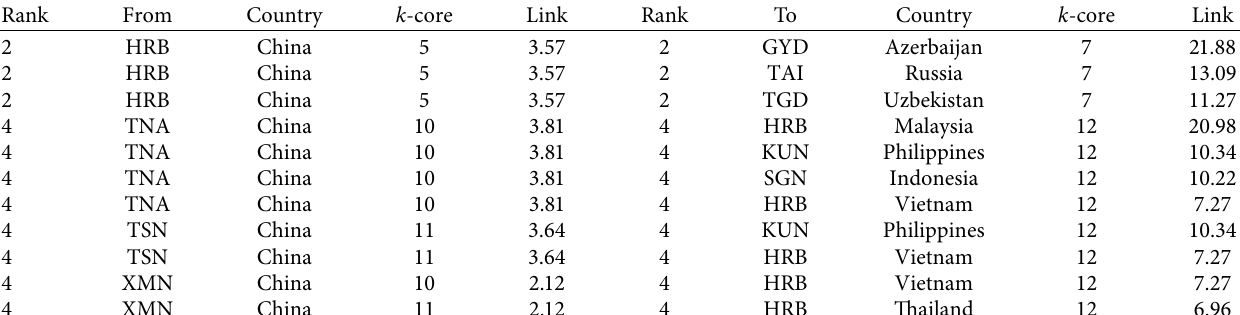
Table 7: Scheme 2 for deep integration into the key node set of the same community.